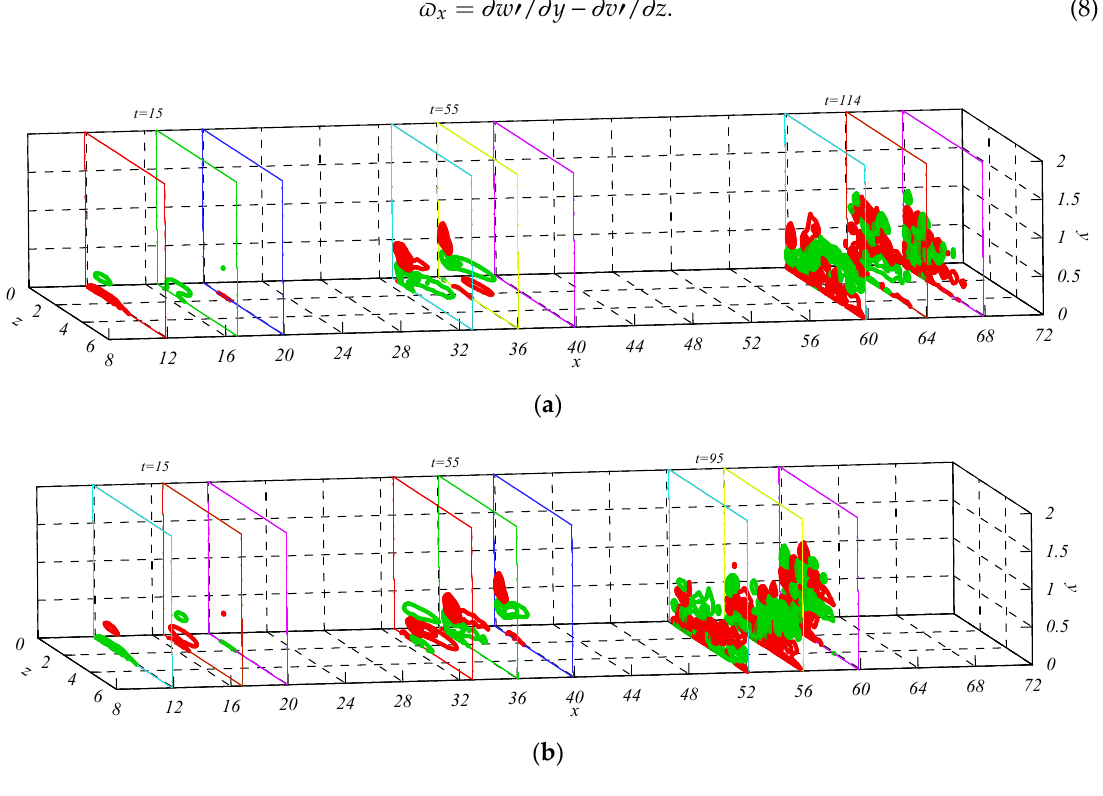
13 of 14 Figure 6. Mean stream-wise velocity and flow stability: ( a ) t = 114; ( b ) t = 95; ( c ) neutral curve; ( d ) growth rate.